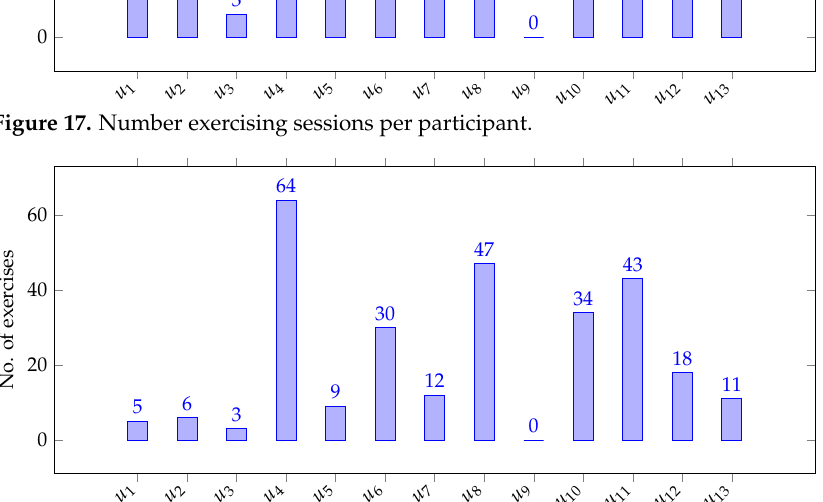
Figure 18. Number of completed exercises per participant.